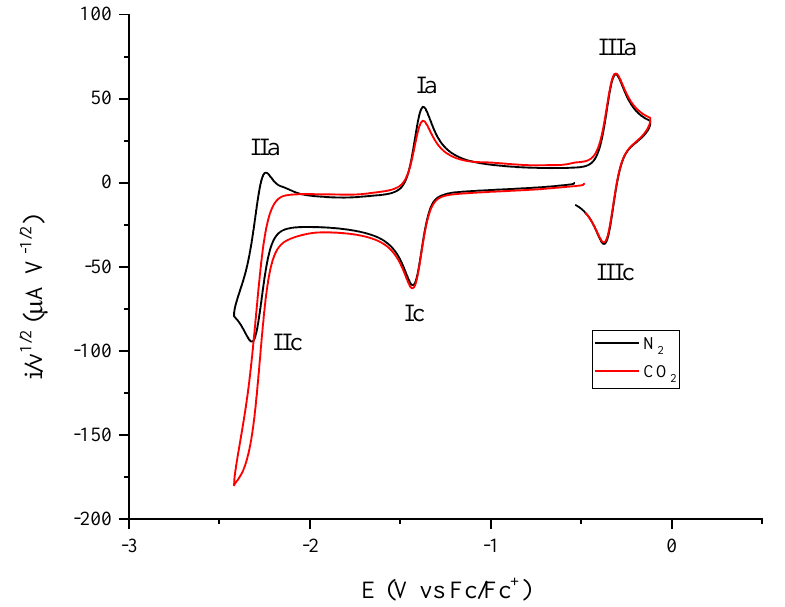
Figure 7. Normalized current cyclic voltammetry of 1 mM [Co II (terpy) 2 ](BF 4 ) 2 solution in MeCN with 0.1 M of TBAPF 6 as supporting electrolyte, bubbled with N 2 (black line) and CO 2 (red line) obtained from open-circuit potential to cathodic direction. Glassy carbon disk as a working elec- trode.